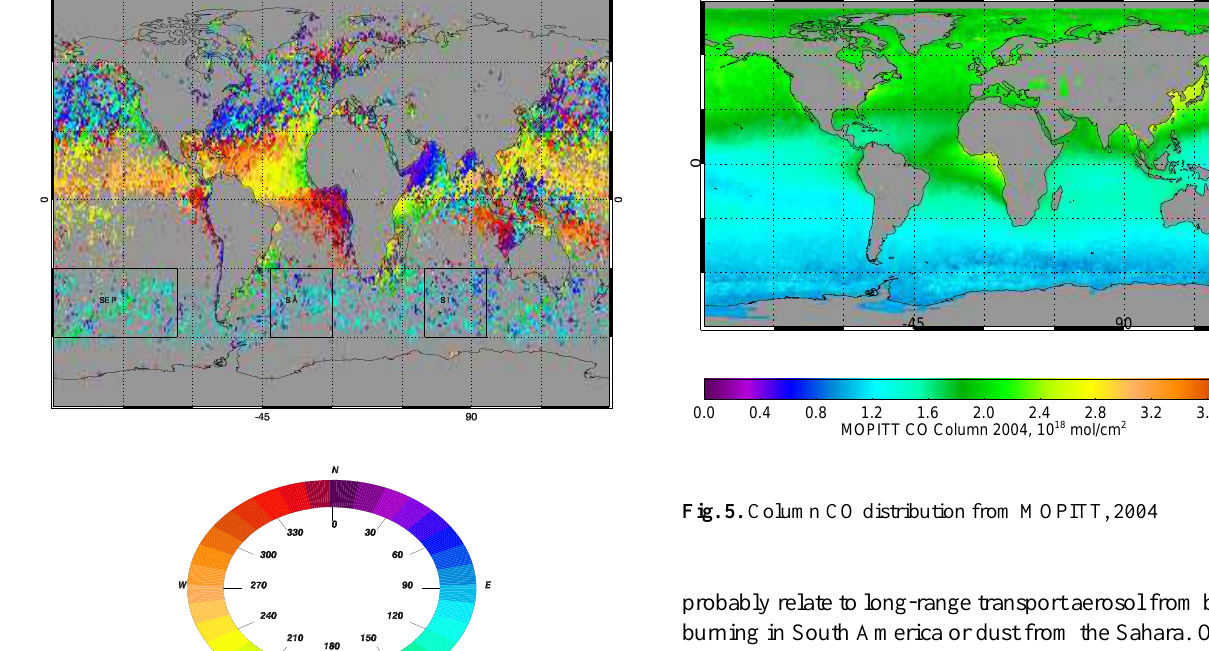
Fig. 5. Column CO distribution from MOPITT, 2004